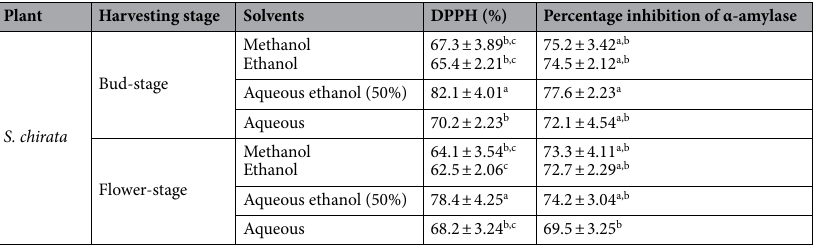
Table 5. Antioxidant and anti-diabetic activity of S. chirata leaves harvested at different plant phases and extracted with different solvents.